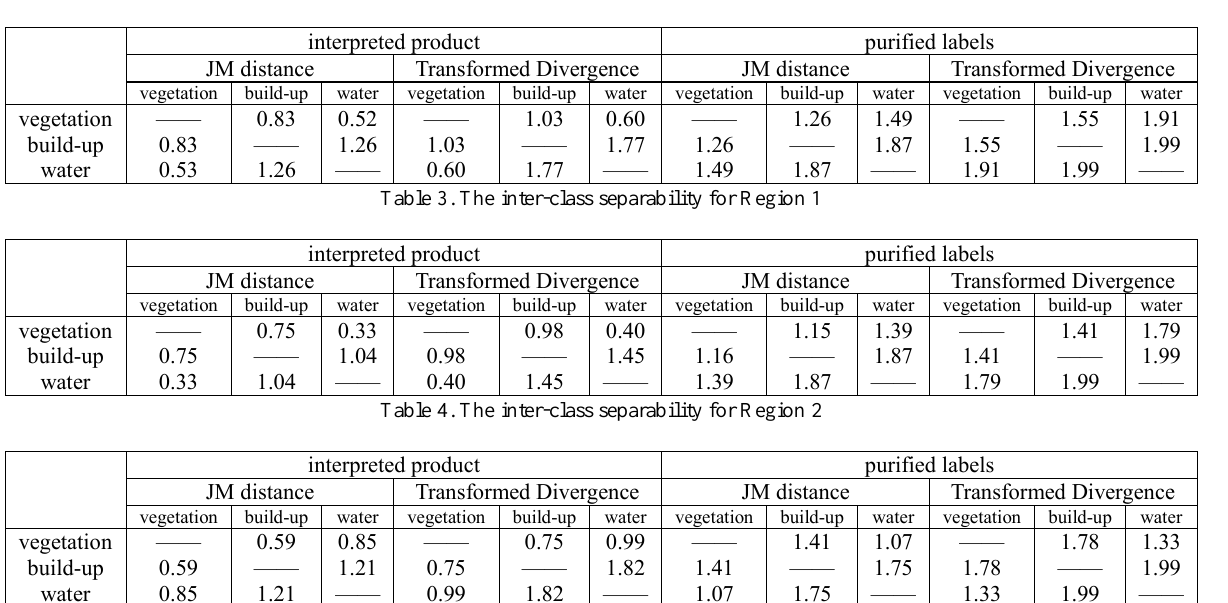
Table 2. The intra-class purity for the interpreted product and purified labels of three test images